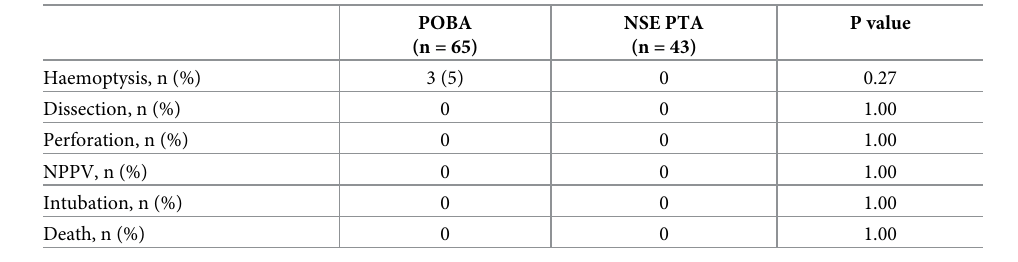
Table 5. Incidence of complications.